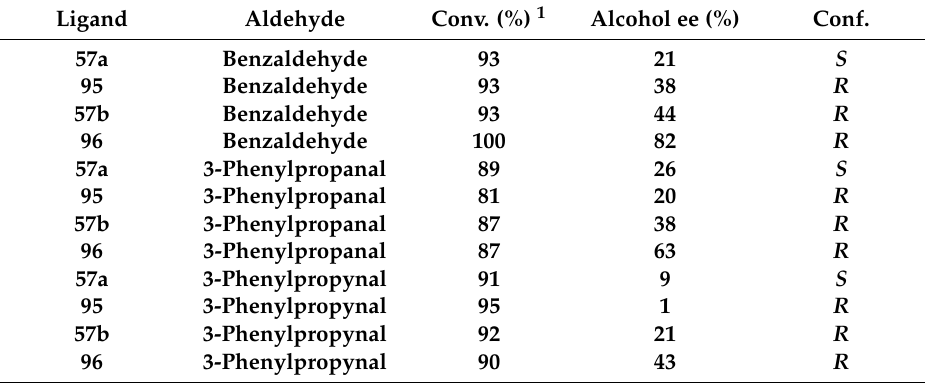
Table 5. Asymmetric addition of ZnEt 2 to aldehydes